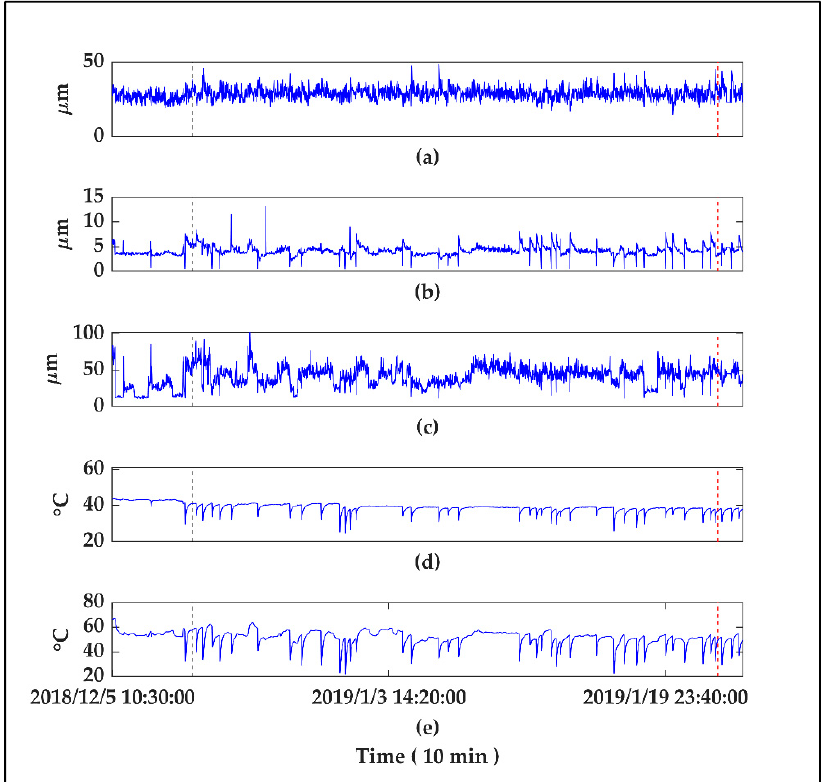
Figure 12. The changing curve of correlation monitoring parameters of hydropower units in case 3: ( a ) vibration of oil receiver in the Y direction, ( b ) vibration of combined bearing in the Y direction, ( c ) vibration of water guide bearing in the Y direction, ( d ) temperature of forwarding thrust bearing bush, ( e ) temperature of the stator core.